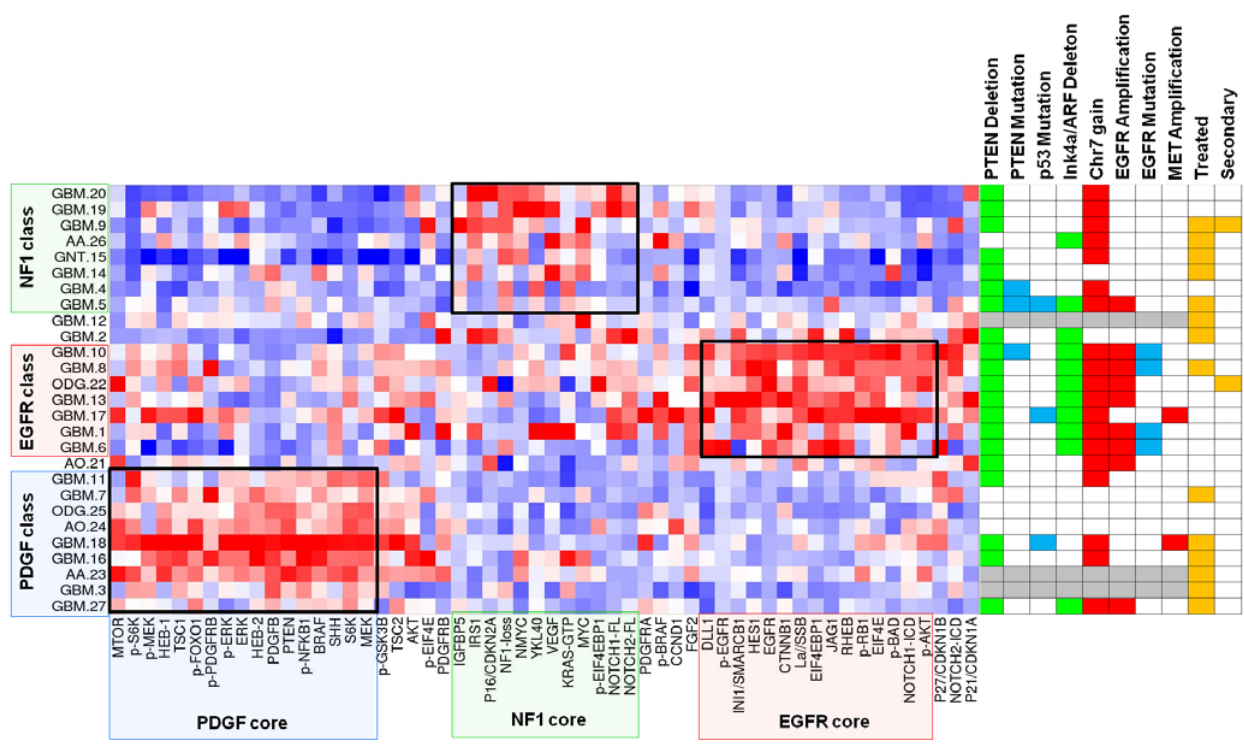
Figure 2. K-means clustering of gliomas by signature-defining proteins. Unsupervised k-means clustering of 27 gliomas by 44 core proteins derived from Figure 1B. 3-way clustering was determined to be the best fit by consensus matrix stability and cophenetic correlation (Figure S3). Right: summary of array-CGH, sequencing and clinical information is given for each tumor. Red denotes copy number gain or focal amplification as specified; green marks deletion of at least one copy. Blue denotes mutations (see text). Gray marks samples for which DNA was unavailable. Detailed aCGH profiles shown in Figure S4.